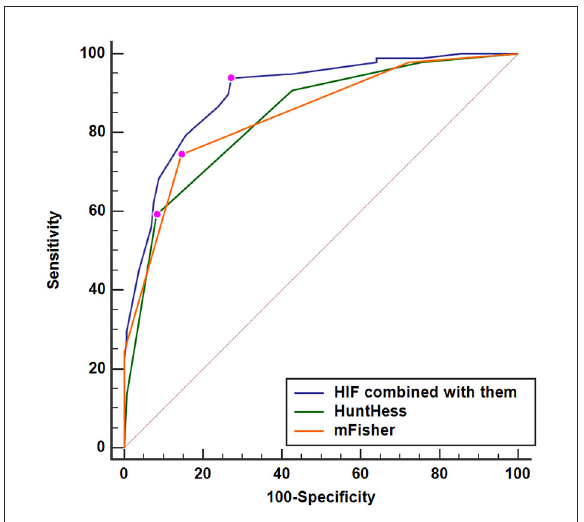
FIGURE10 Predictive ability with respect to serum hypoxia-inducible factor 1alpha levels combined with Hunt–Hess scores and modified Fisher scores for poor outcome. Serum HIF-1 α levels combined with Hunt–Hess scores and modified Fisher scores displayed substantially elevated discriminatory capability for poor outcome in comparison to Hunt–Hess scores and modified Fisher scores alone ( P < 0.01). HuntHess, Hunt–Hess scores; mFisher, modified Fisher scores; HIF, hypoxia-inducible